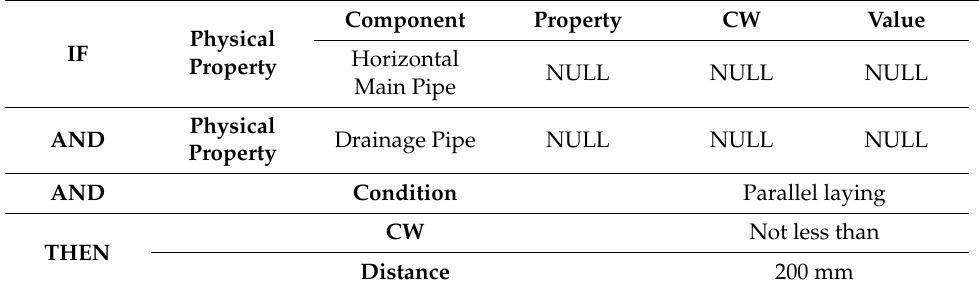
Table 4. An example of optimizing the component spacing rule including laying